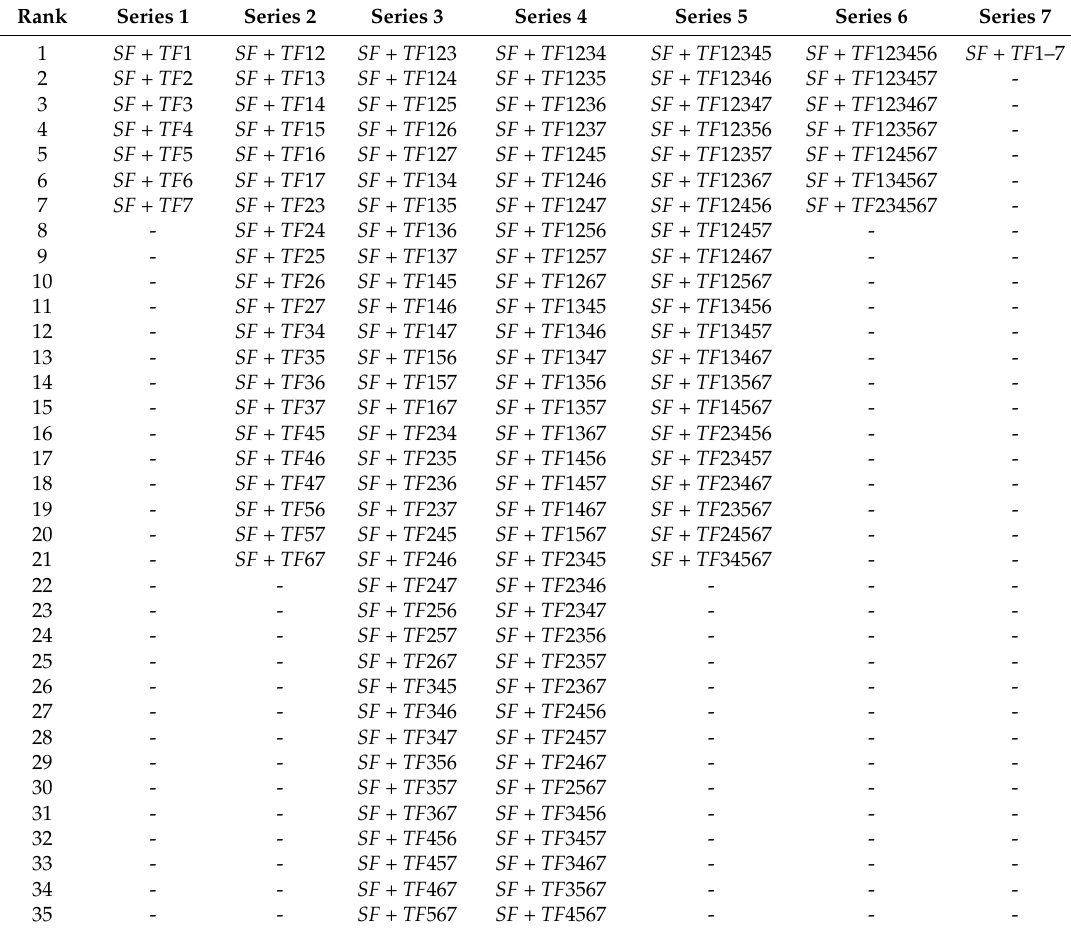
Table 2. Different combinations of spectral and textural vectors a